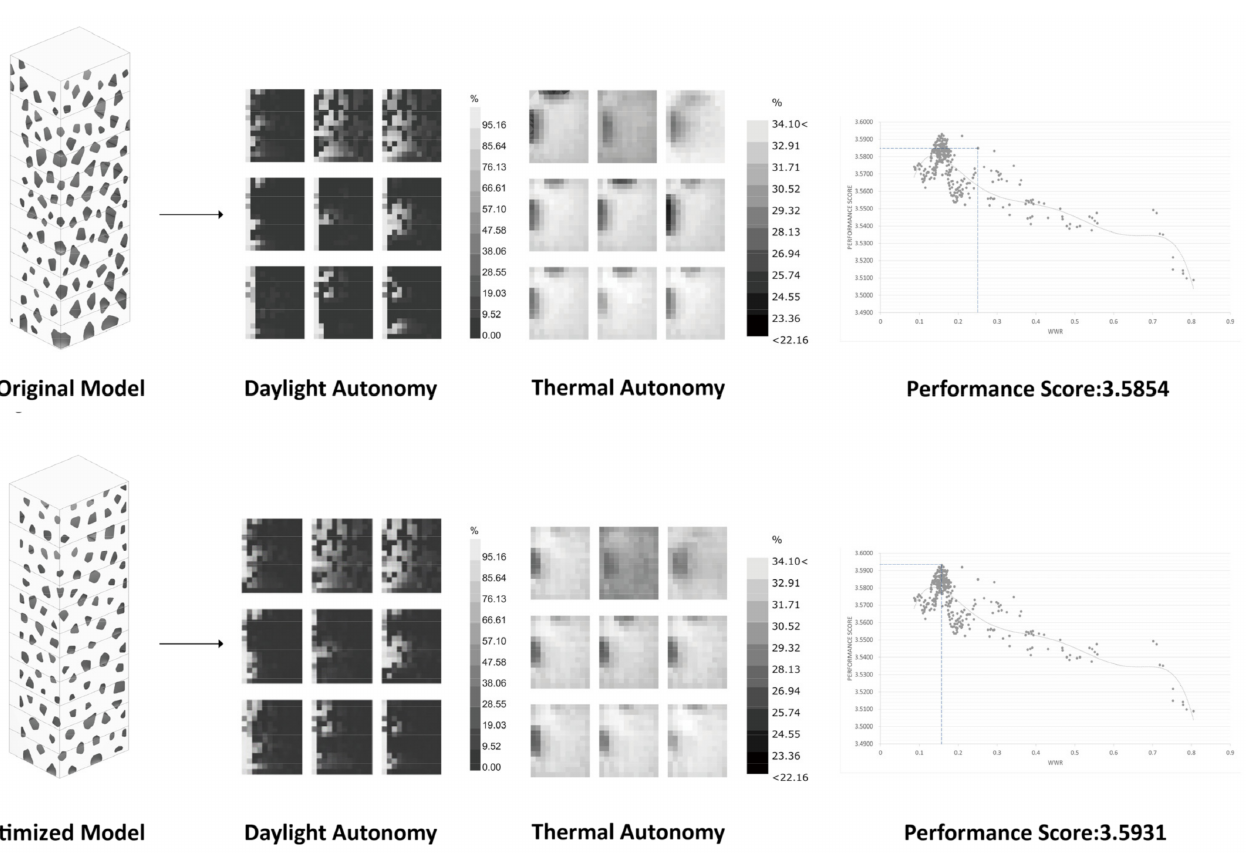
Figure 20. Comparison of the original and the optimized results.